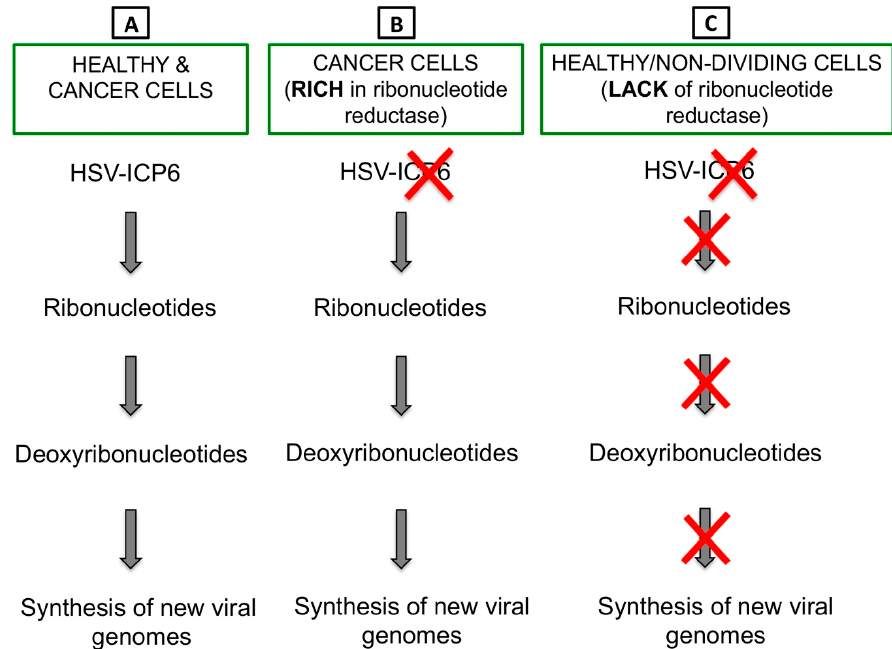
Figure 3. ICP6 inactivation drives tumor-specific replication of OHSV-IL12. ( A ) ICP6 encodes for large subunit of ribonucleotide reductase, which controls nucleotide metabolism and helps HSV to replicate in normal or healthy host cells that are inherently lacking or have insufficient nucleotide pools. ( B ) Cancer cells are rich in ribonucleotide reductase, thus HSV with an inactivated ICP6 does not hamper DNA synthesis in cancer cells. ( C ) Healthy or non-dividing cells lack ribonucleotide reductase. Thus, infection of healthy cells with an ICP6-inactivated HSV leads to no nucleotide metabolism and no viral DNA replication.